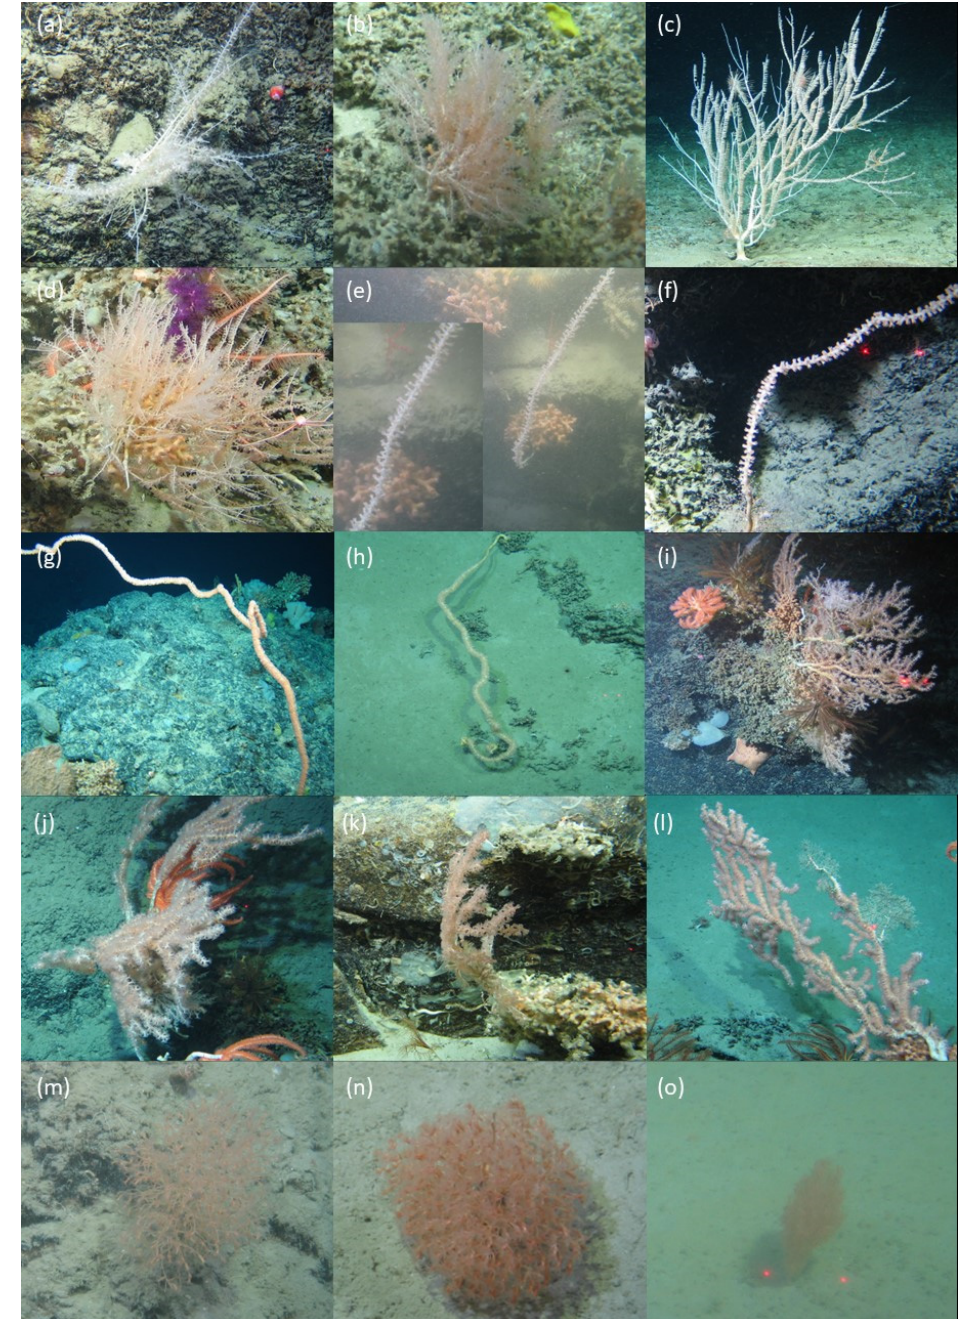
Figure 3. In situ photographs taken by ROV Holland I representing the gross morphology of ( a ) Haplotype 13 (M16), ( b ) Haplotype 13 (M17), ( c ) Haplotype 13 (M18), ( d ) Haplotype 14 (M17), ( e ) Haplotype 15 (M19), ( f ) Haplotype 16 (M28), ( g ) Haplotype 16 (M29), ( h ) Haplotype 17 (M30), ( i ) Haplotype 18 (M20), ( j ) Haplotype 19 (M21), ( k ) Haplotype 19 (M22), ( l ) Haplotype 20 (M23), ( m ) Haplotype 21 Acanella arbuscula (M24), ( n ) Haplotype 21 A. arbuscula (M25), and ( o ) Haplotype 21 A. arbuscula (M26).